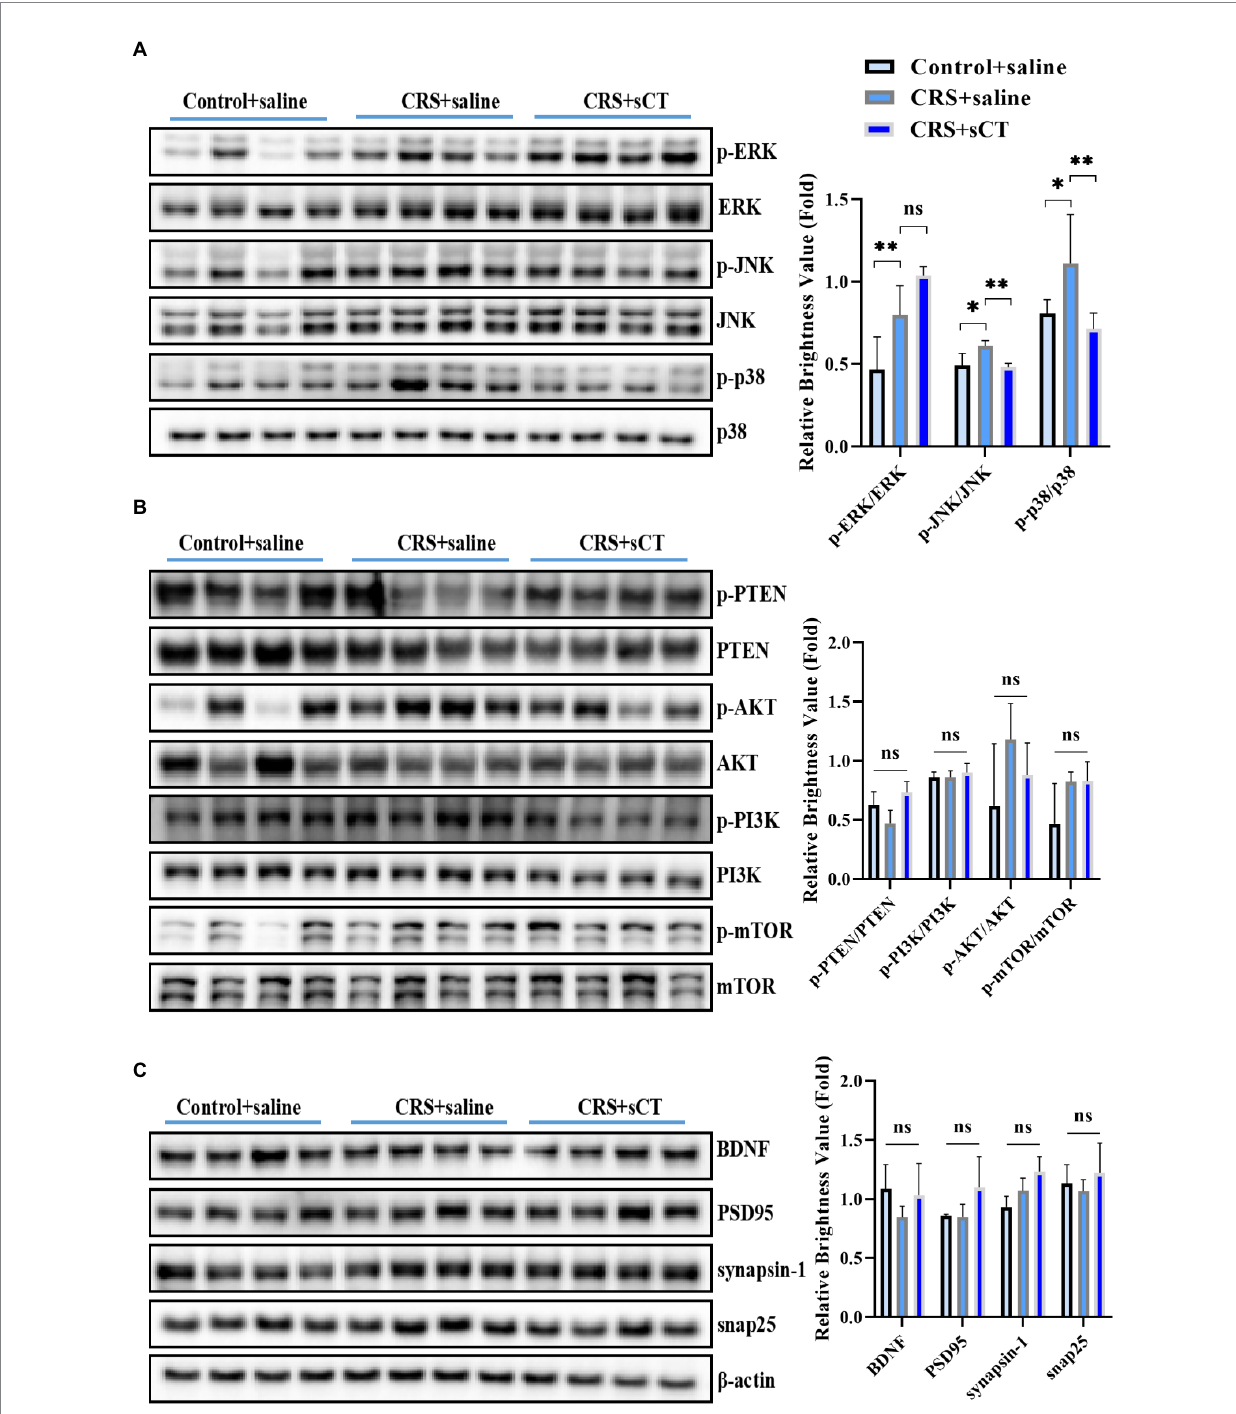
FIGURE 4 sCT treatment blocked the p38/JNK signaling pathway in the hippocampus of CRS-treated mice. (A) The phosphorylation levels of ERK/p38/JNK in the hippocampus of control mice, CRS-treated mice and CRS-treated mice with sCT treatment. (B) The phosphorylation levels of PTEN/PI3K/AKT/mTOR in the hippocampus of control mice, CRS-treated mice, and CRS-treated mice with sCT treatment. (C) The expression of BDNF/PSD95/synapsin-1/ snap25 in the hippocampus of control mice, CRS-treated mice and CRS-treated mice with sCT treatment. The data were analyzed by one-way ANOVA with Tukey’s multiple comparisons tests. * p < 0.05, ** p <